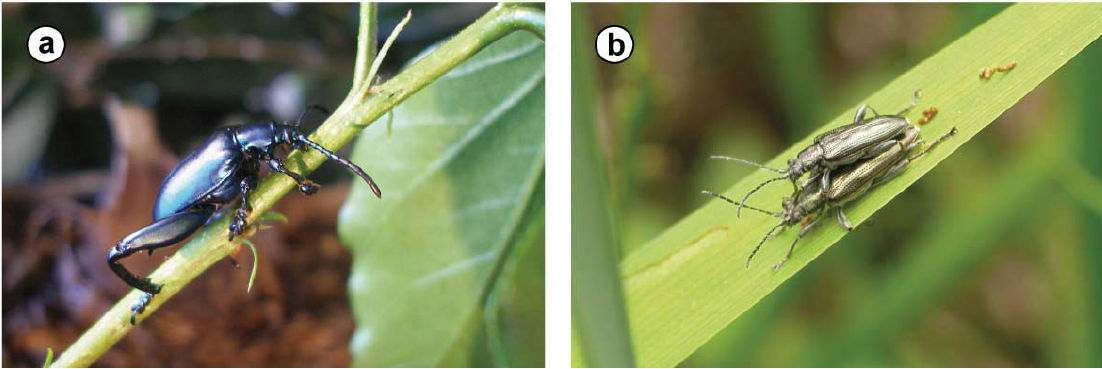
Figure 1. Representatives of (a) the Sagrinae ( Sagra femorata , 22 mm long) and (b) the Donaciinae (pair of Donacia cf. subtilis Kunze, 1818, 10 mm